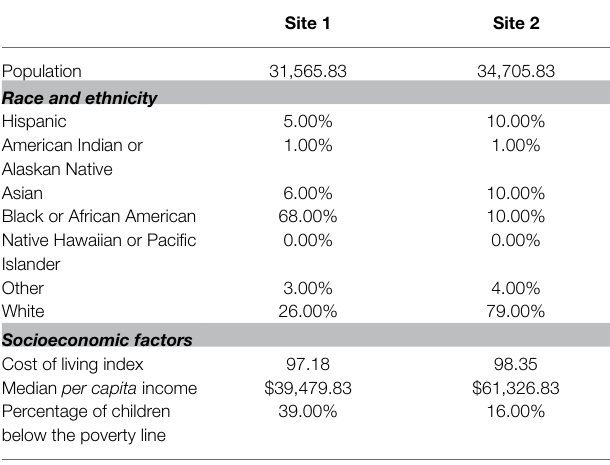
TABLE 2 | Demographic and socioeconomic factors for the two target recruitment sites (set of zip codes targeted in the Facebook ad) as reported on the American Community Survey (ACS) 5-year